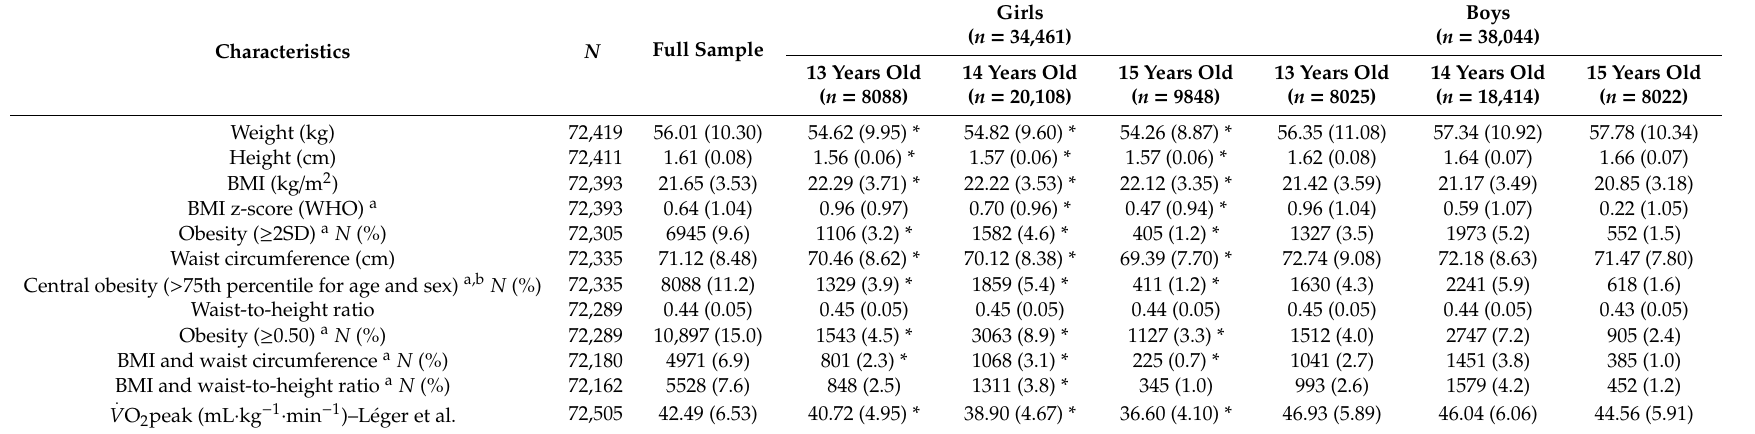
Table 1. Characteristics of the sample by age and sex group.